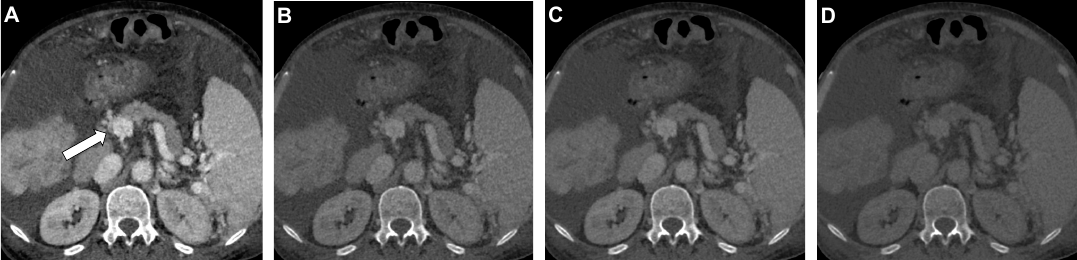
Figure 4. Coronal DECT images of a 67-year-old man with subtle portal vein thrombosis at the confluence of the superior mesenteric and splenic vein ( arrow ). The thrombus is best visible in 40 keV noise-optimized virtual monoenergetic imaging (VMI+) ( A ), followed by the 60 keV VMI+ series ( B ), whereas the detection using 60 keV VMI ( C ) and standard M_0.6 ( D ) series is